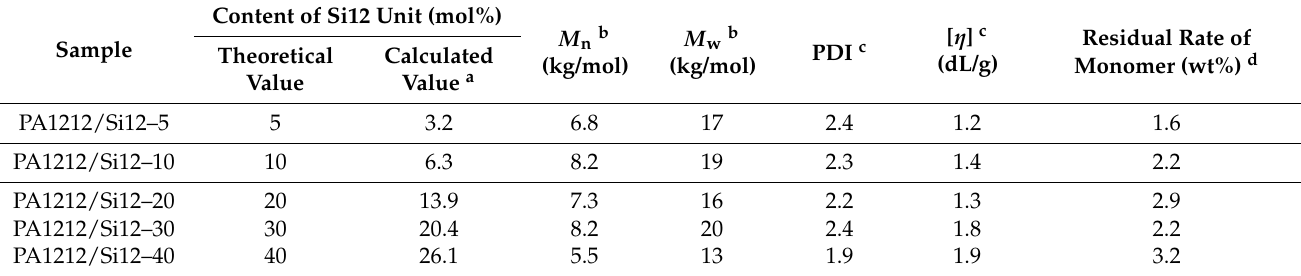
Table 1. The parameters of the